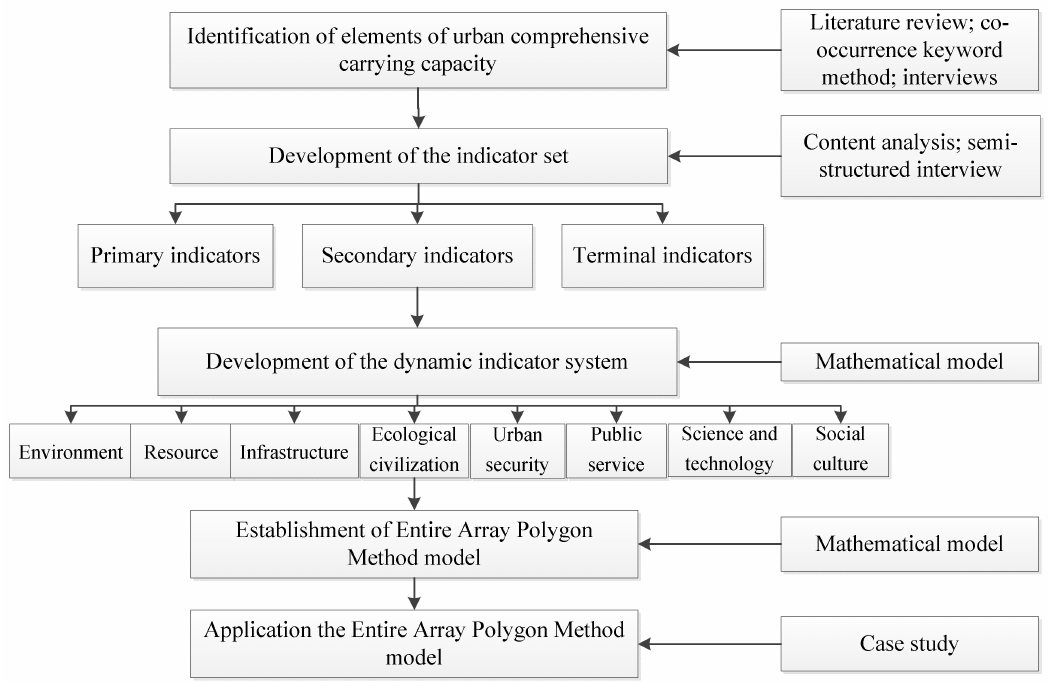
Figure 1. Flowchart of the